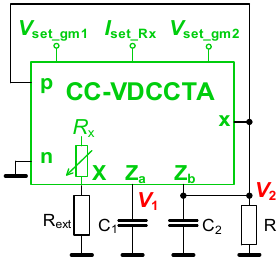
Figure 12. A simple electronically and linearly tunable quadrature oscillator based on CC-VDCCTA. Simultaneous adjustment of R X + R ex t and g m 1 ( g m 1 = 1 / ( R X + R ext )) ensures linear tuning of the